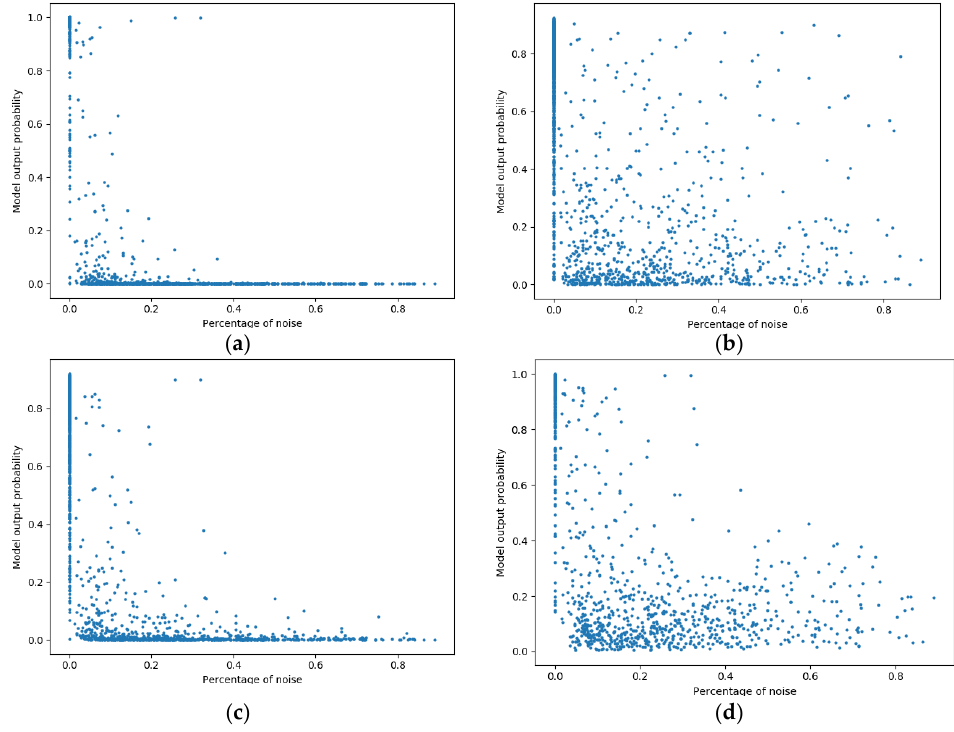
Figure 4. Scatter plots for the results of different probability predictions after adding a percentage of label noise to the PPG records in the initial training data: ( a ) trained on clean data; ( b ) trained with 10% random label noise; ( c ) trained with 10% good-to-bad switching as label noise; ( d ) trained with 10% bad-to-good switching as label noise.